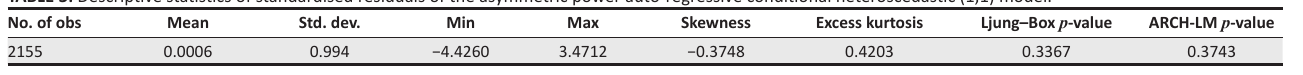
TABLE 3: Descriptive statistics of standardised residuals of the asymmetric power auto-regressive conditional heteroscedastic (1,1) model. No. of obs Mean Std. dev.